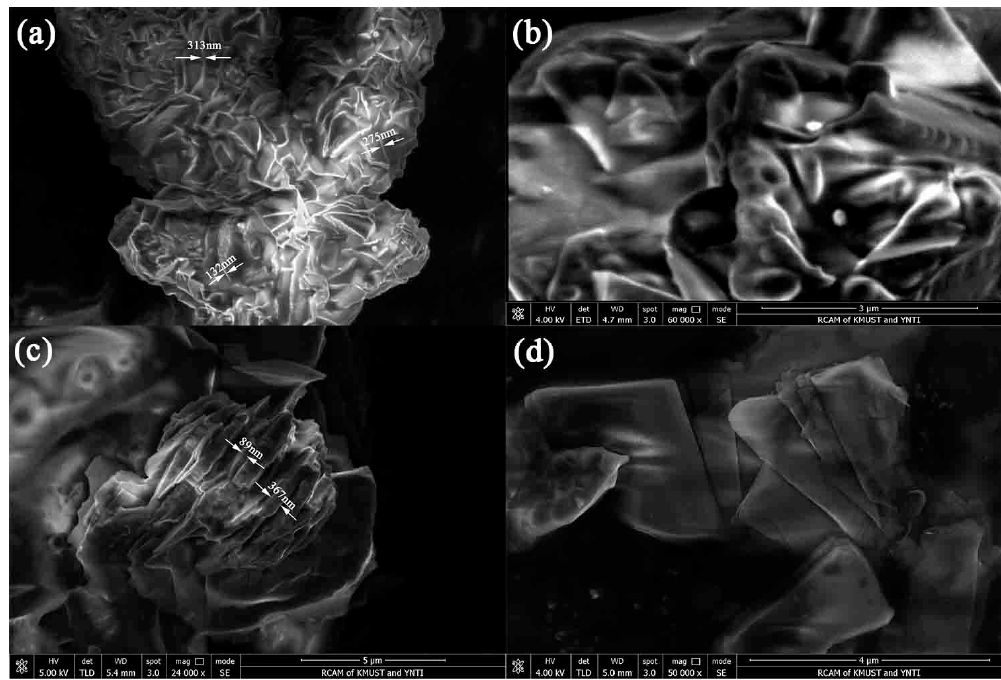
Figure 6. SEM images of PBT nanosheets synthesized with ( a , b ) an H 2 O 2 /BT molar ratio of 3.53 and an initial BT concentration of 58.25 mmol L − 1 , and ( c , d ) an I 2 /BT molar ratio of 1.5 and an initial BT concentration of 50 mmol L − 1 in ethanol at 25 °C for 24 h.